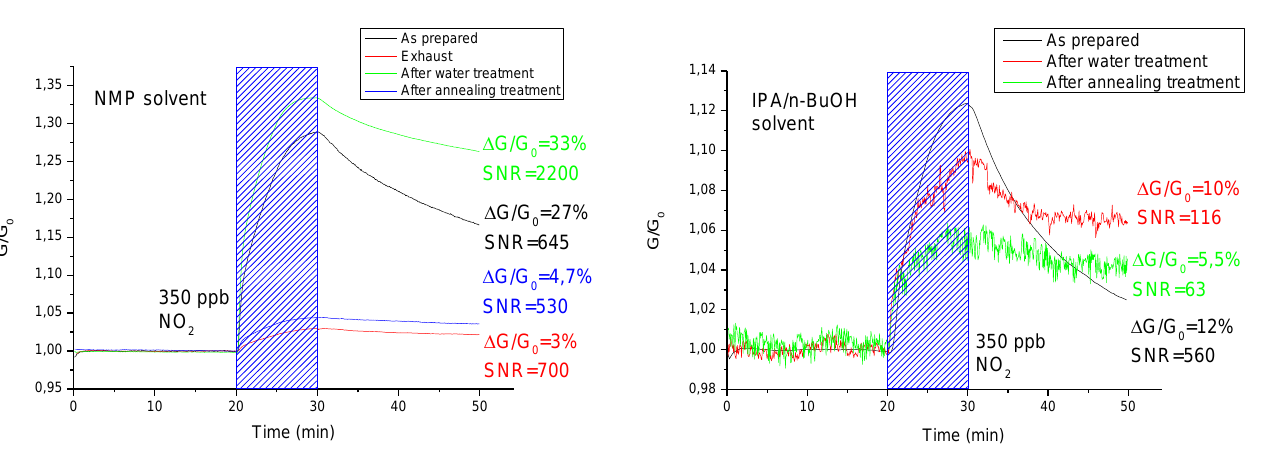
Figure 2. Normalized electrical conductance behaviors for chemi-resistors towards 350ppb of NO 2 in a wet N 2 environment as soon as prepared (black line), after the restoration by the dipping method (red line), and after the restoration by the annealing method (green line). The standard protocol adopted in these tests consists of the baseline of 20min in wet N 2 and the window exposure of 10min to NO 2 (blue dashed color area in the figures). In this case, the graphene solution was prepared by exfoliating graphite flakes in a mixture of IPA/n-BuOH solvent.